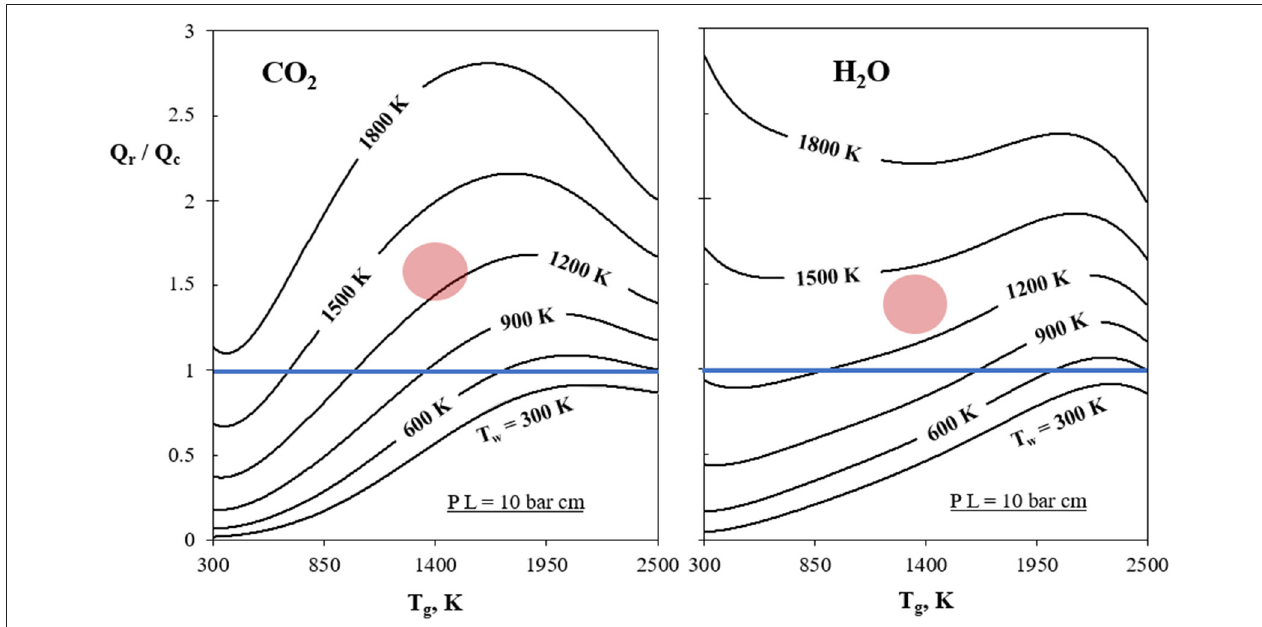
FIGURE 2 | Trends of the ratio between radiation and convection for CO 2 (left) and H 2 O (right) as a function of the mean gas temperature and at different wall temperatures, for a small-scale cyclonic reactor (Sorrentino et al., 2018).